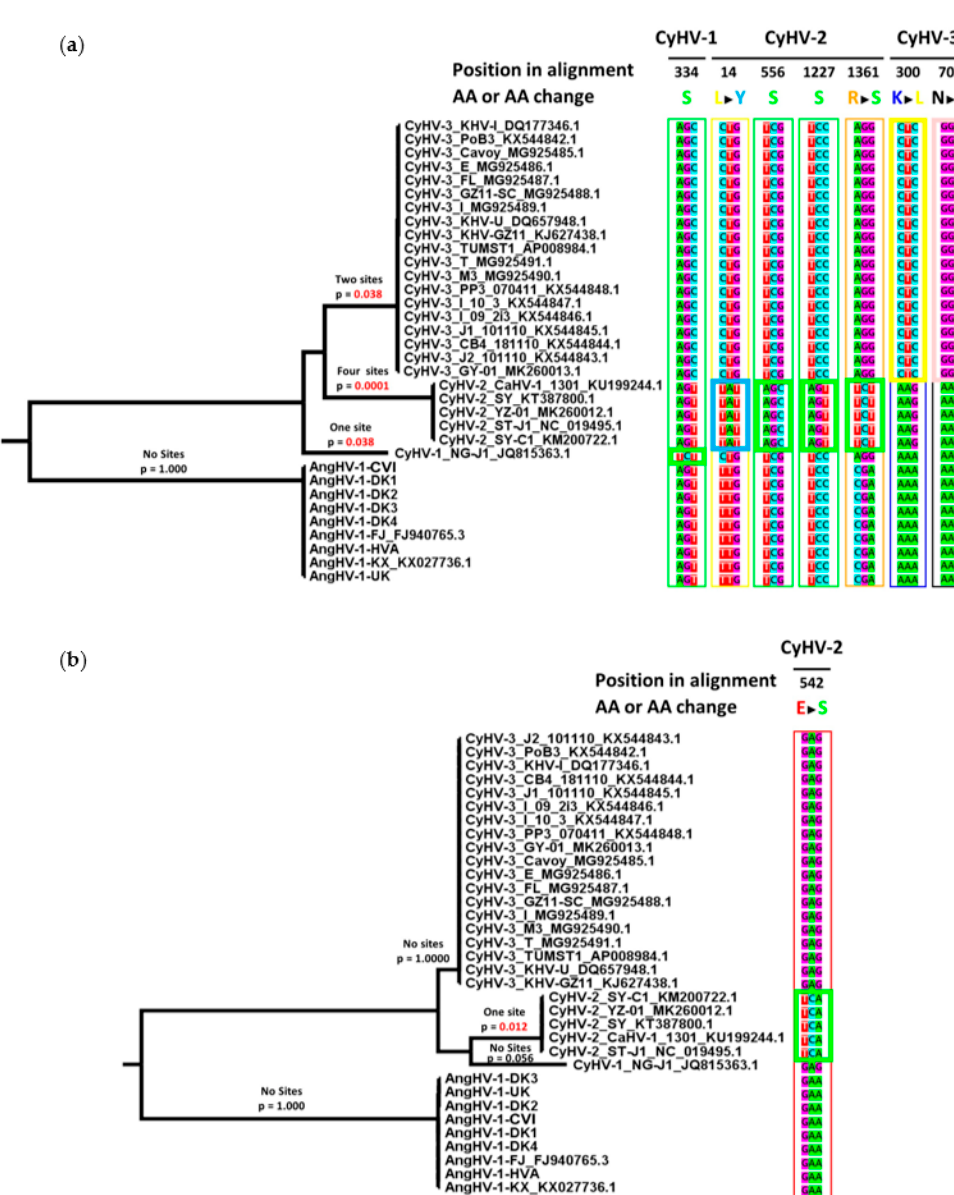
Figure 5. AA changes in cyprinivirus core genes driven by positive selection. CodeML analysis was performed to identify AA changes between cyprinivirus species that were driven by positive selection. Positive selection was identified in the ( a ) DNA polymerase and ( b ) helicase genes. The ML trees based on DNA polymerase and helicase codon alignments are displayed. A summary of results and p -values are indicated above each branch of interest. Only changes supported by PP > 0.95 are shown. Codon and AA changes are displayed to the right of each tree, with position in alignments and color-coded descriptions of codon changes indicated on top of each column. Boxes around codons in each column are colored corresponding to the color-coded codon changes on top of each column, with codons representing the changes driven by positive selection indicated by thicker lines. PP values and species-specific positions of AA sites are summarized in Table 3.